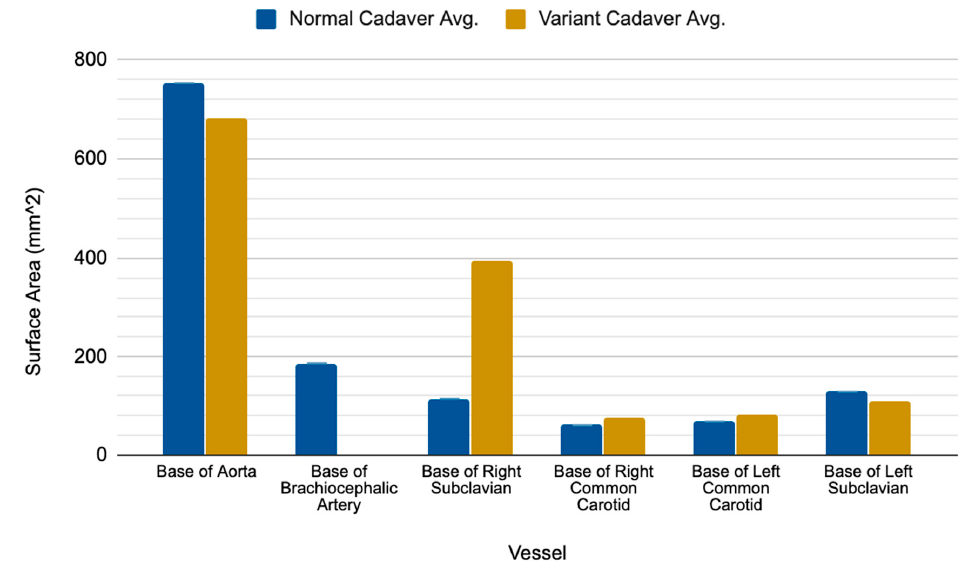
Figure 2. Comparative results showing the surface area measurements of aortic branches in the normal versus ARSA variant subjects. The surface areas at each location were averaged for each group.